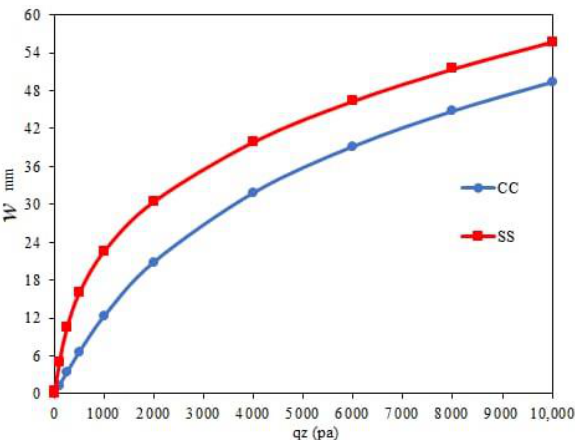
Figure 6. Deflection changes versus the applied transverse loading ( 𝑞 𝑧 ) for different types of bound- ary conditions. boundary